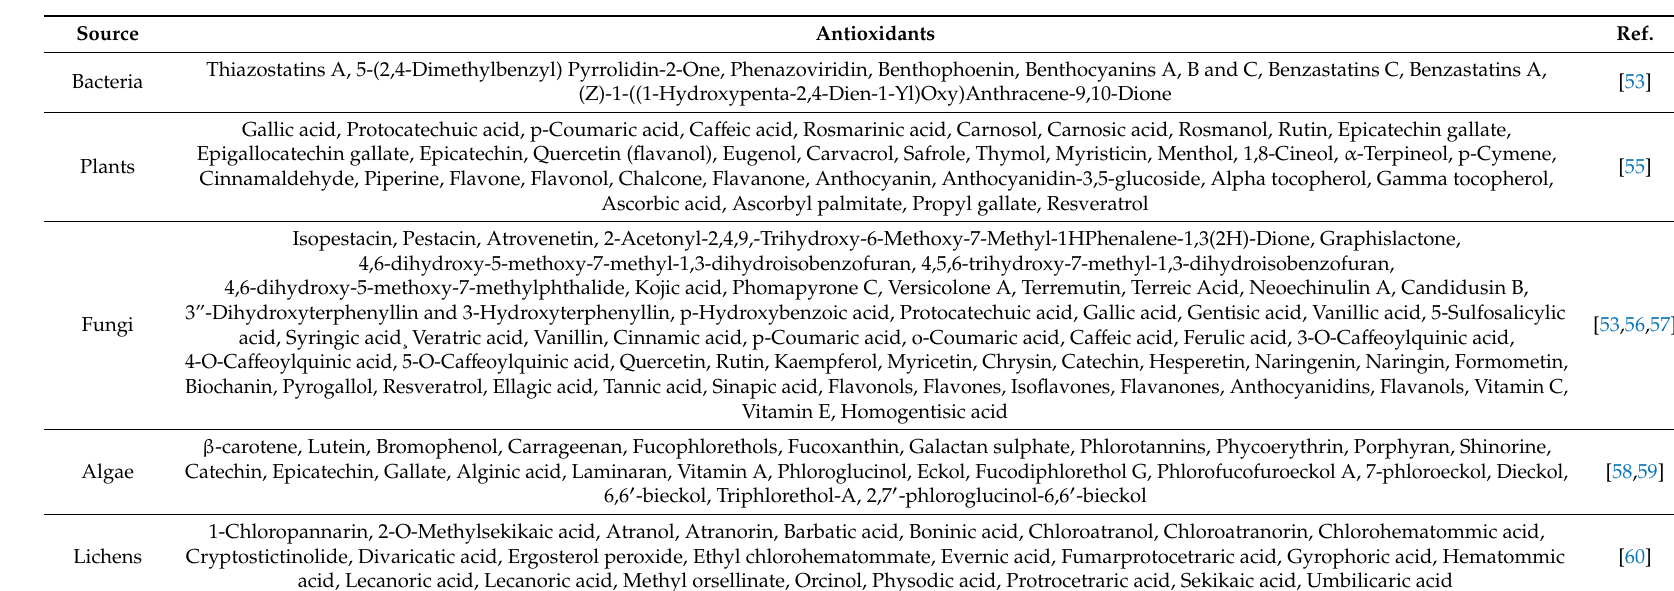
Table 1. Antioxidants from di ff erent biological